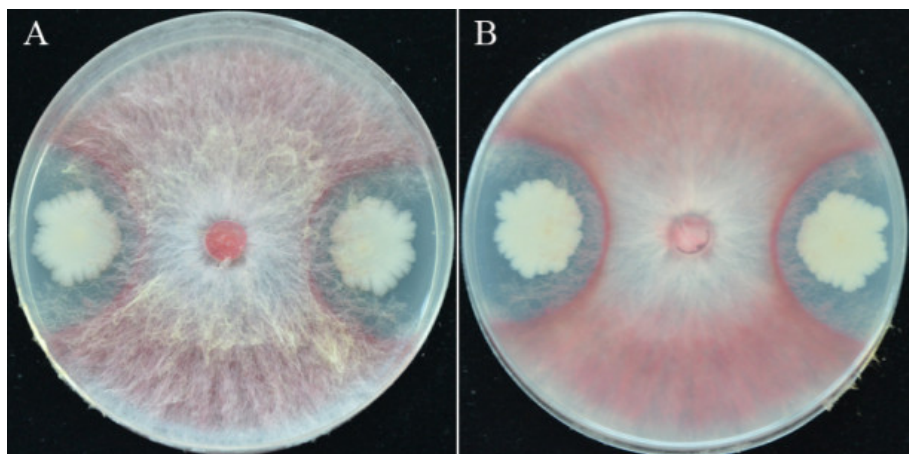
Figure 1. Characteristics of strain YB-15: ( A , B ) Dual culture of F. pseudograminearum and strain YB-15 on PDA.